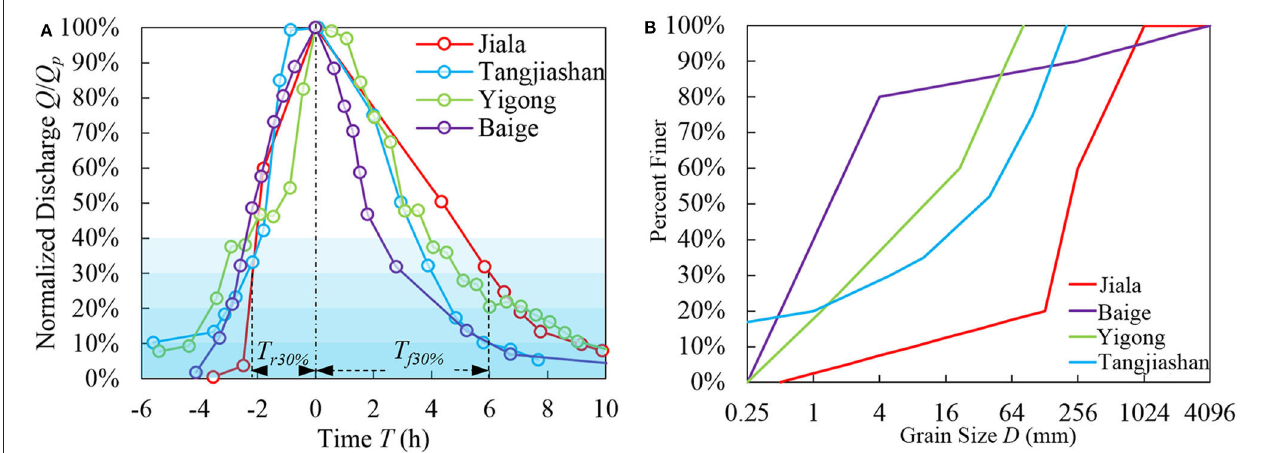
FIGURE 13 | Observation data of four typical landslide dams. (A) Normalized outburst flood hydrographs, where T r 30 % and T f 30 % in the figure correspond to the outburst hydrograph of the Jiala landslide dam; (B) GSDs of four landslide dams, among which the GSDs of the Tangjiashan barrier dam and Yigong barrier dam are measured by field survey and the GSDs of the Jiala barrier dam and Baige barrier dam are estimated by images and then verified by simulation.